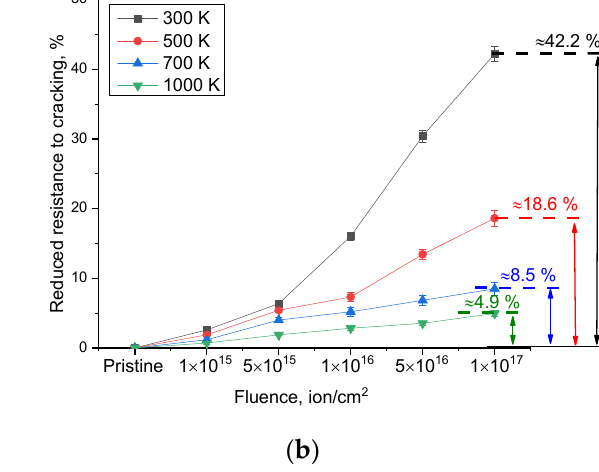
Figure 7. ( a ) Results of the change in the crack resistance value of ceramics depending on the irradiation conditions; ( b ) Results of the change in the crack resistance value, depending on the irradiation conditions.